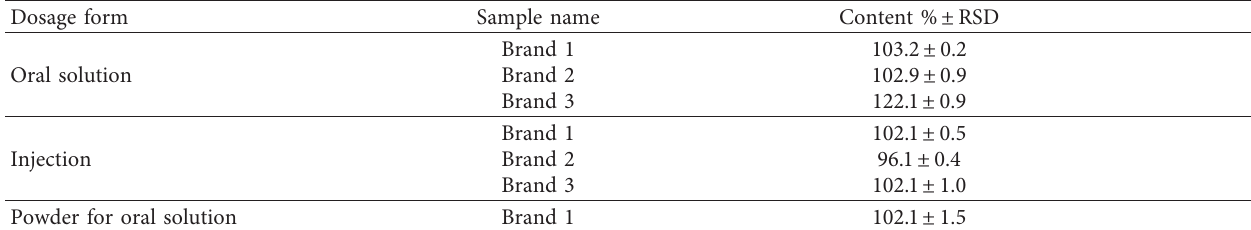
Table 5: Content percentage results.